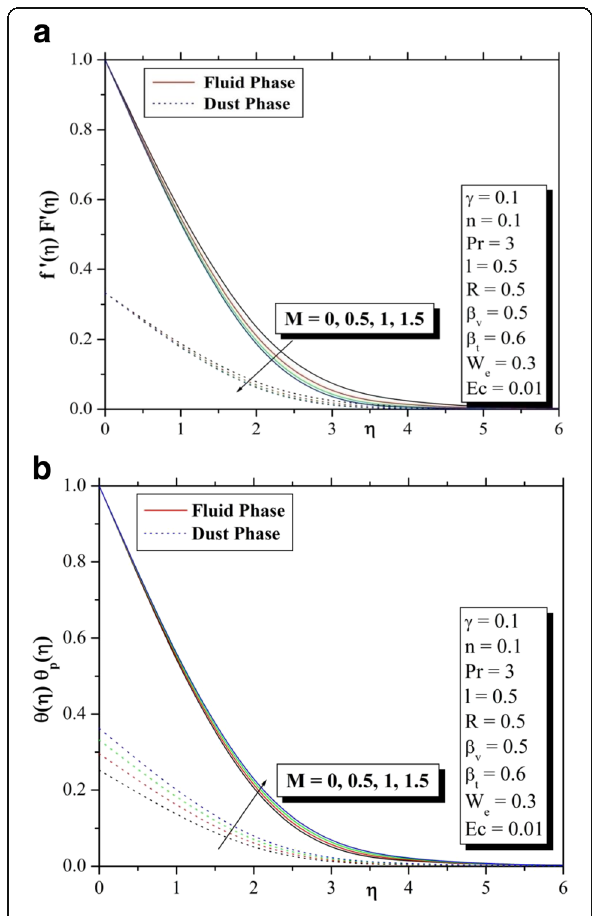
Fig. 3 a , b Velocity profile and temperature profile for different values of